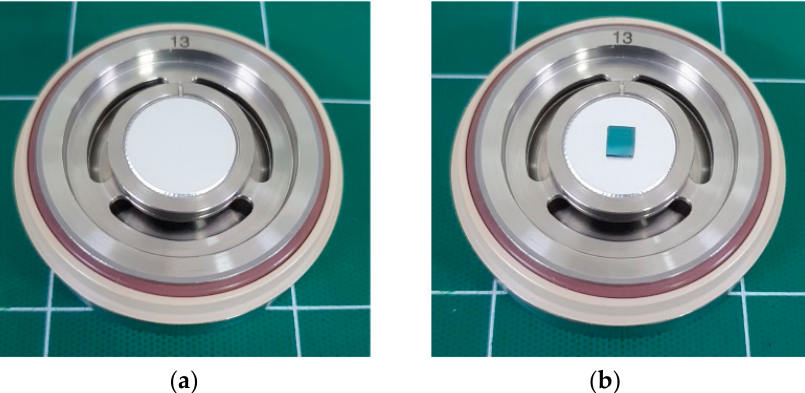
Figure 3. Images of an impactor with different collection substrates. ( a ) Aluminum foil, ( b ) Si wafer.